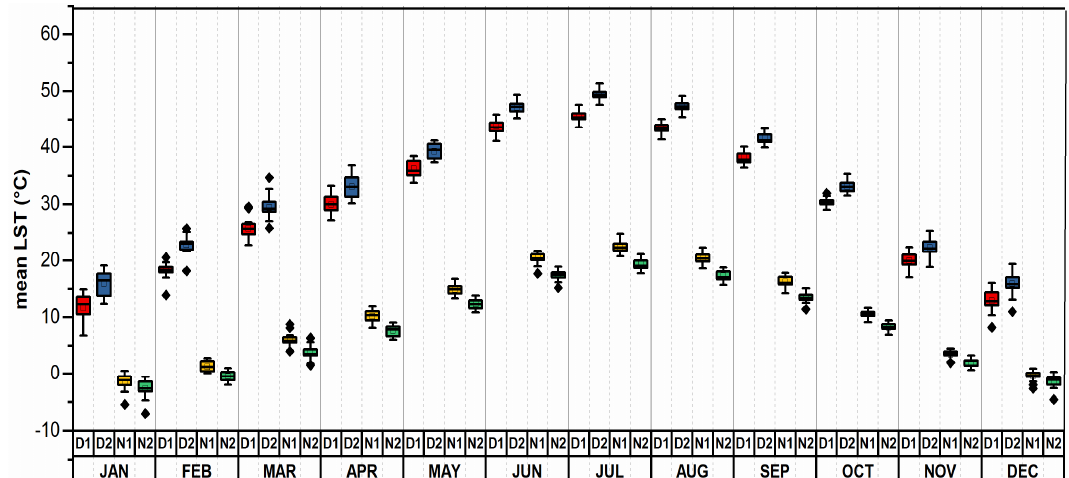
Figure 6. Monthly variation of (average over 2003–2019) during daytime (Terra 10:30 a.m. (D1) and Aqua 13:30 p.m. (D2)) and nighttime (Terra 22:30 p.m. (N1) and Aqua 01:30 a.m. (N2)).